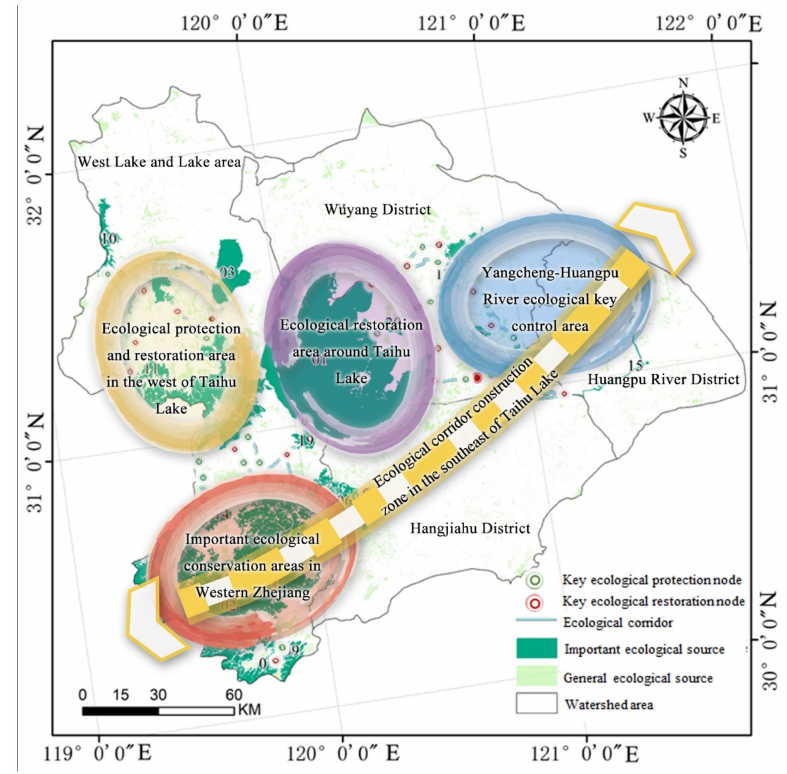
Figure 8. Optimization of the ESP around Taihu Lake